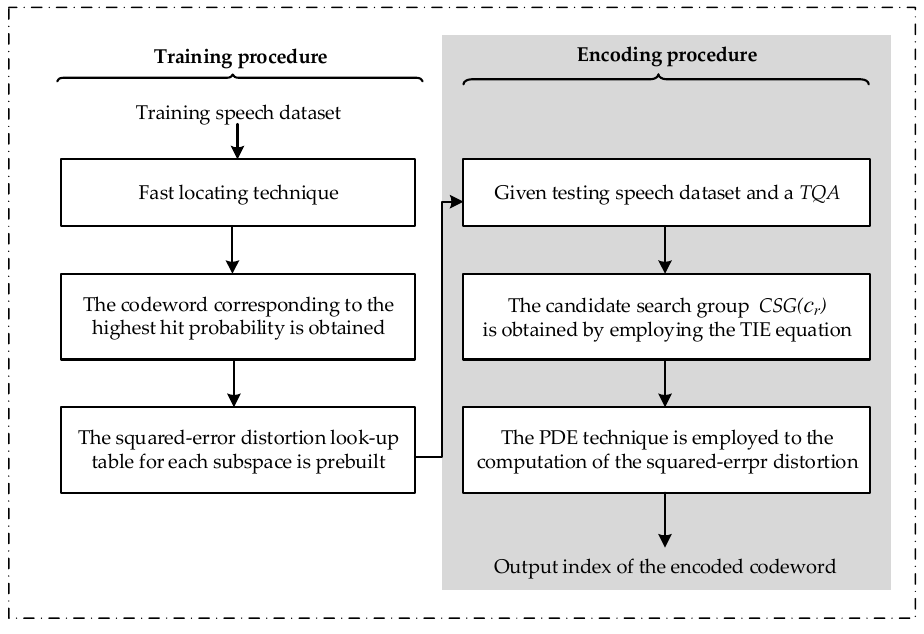
Figure 2. Structure of the proposed search algorithm.